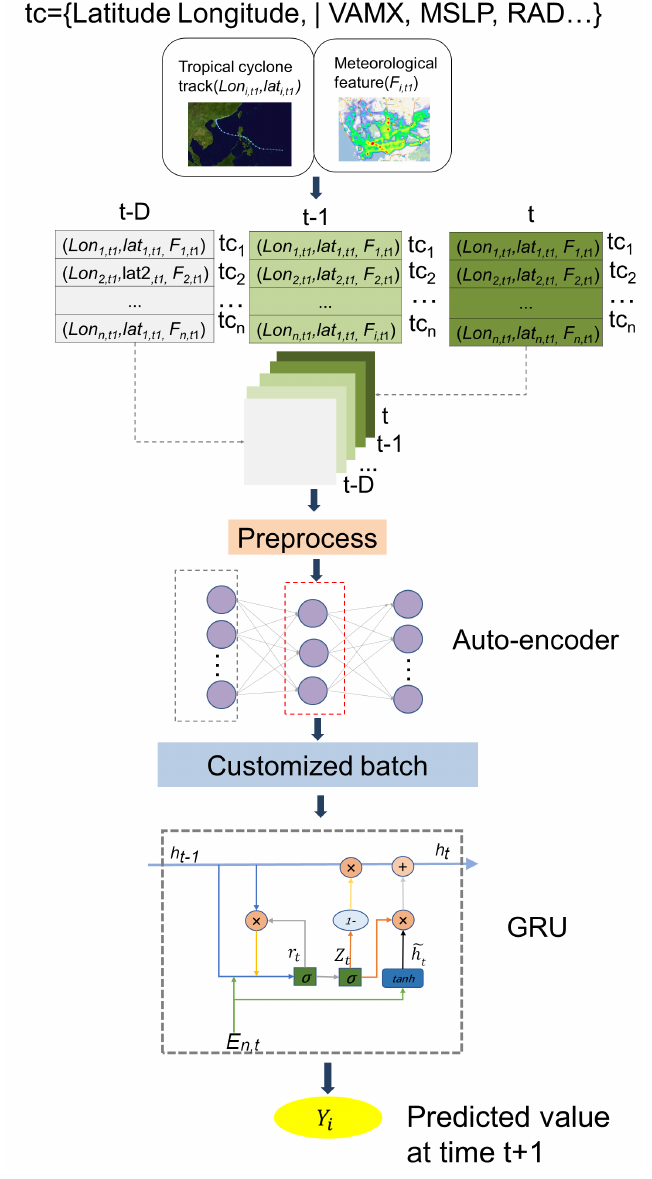
Figure 1. Structure of the AE-GRU